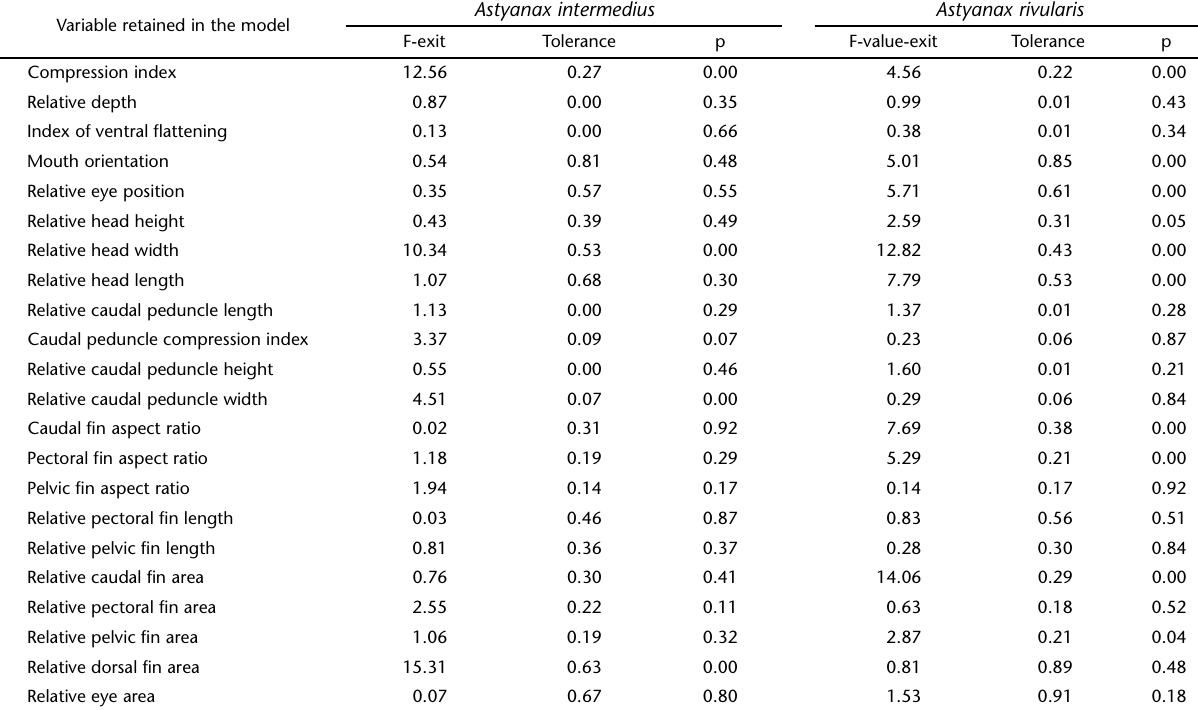
Table III. F values to enter and exit the model and tolerance of the discriminant function analysis for Astyanax intermedius and Astyanax rivularis collected in Rio São Francisco streams in September 2010. Astyanax intermedius Astyanax rivularis Variable retained in the model F-exit